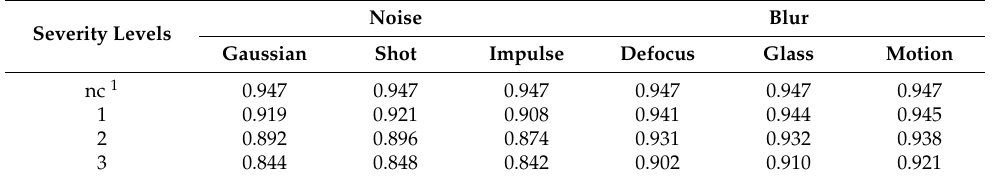
Table 7. Average precision for different noises and blurs at three severity levels obtained by ATSS.